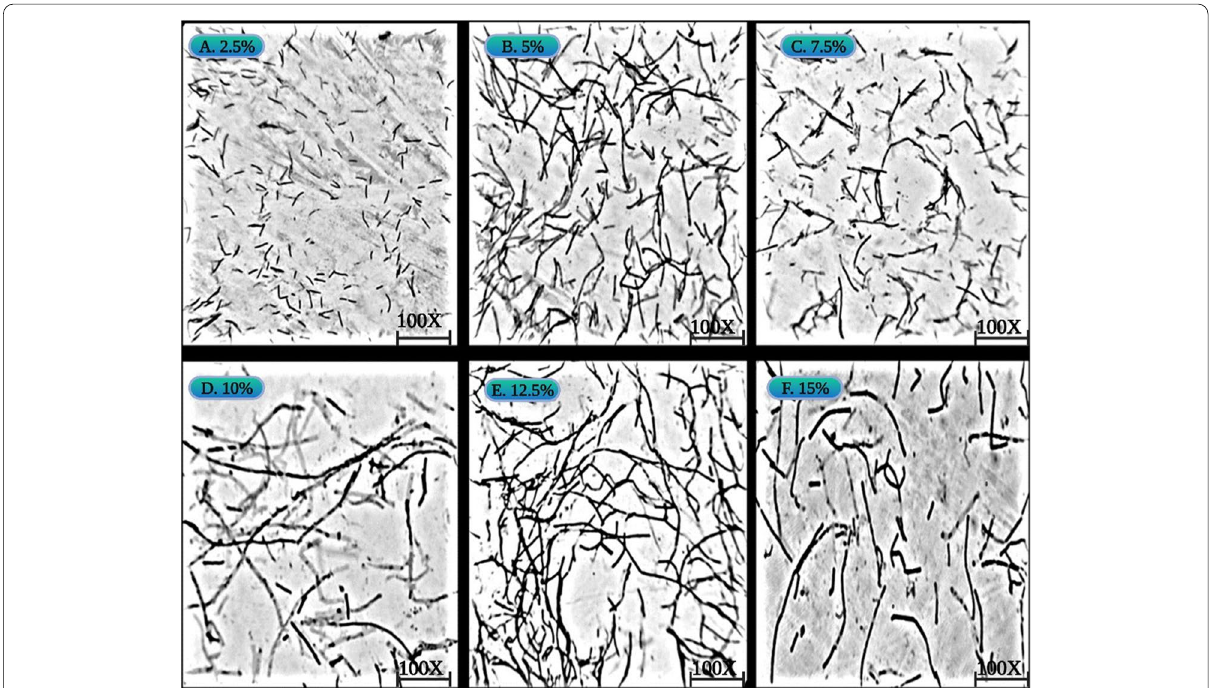
Fig. 5 Effect of salt stress on cell morphology of MHN12 at varying NaCl concentration. a – f 2.5%, 5%, 7.5%, 10, 12.5%, and 15%,